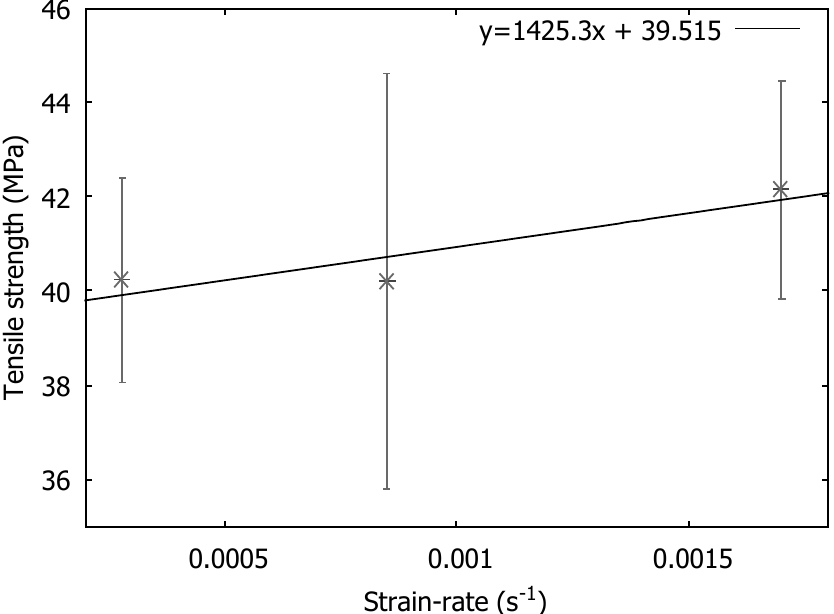
Figure 6. Relation between the average tensile strength against strain rates for 300 µm baggage particle-reinforced polymer composites.